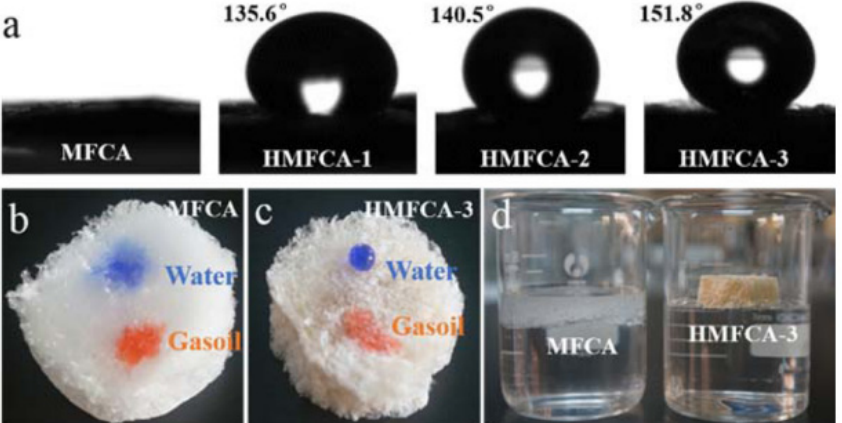
Figure 7. ( a ) Measuring the CA of modified and unmodified microfibrillated cellulose aerogels (MFCAs) with concentrations of 1, 2, and 3 mL of methyltriethoxysilane. ( b , c ) Water/oil differentiation of modified MFCA and unmodified MFCA with 3 mL of methyltriethoxysilane showing that both water and oil are absorbed in the original MFCA, but only oil is absorbed in the modified MFCA. ( d ) MFCA that has been modified floats on water, but MFCA that has not been changed sinks into water. Reproduced with permission from Zhou et al. [93]. ACS publications copyright © 2016 .